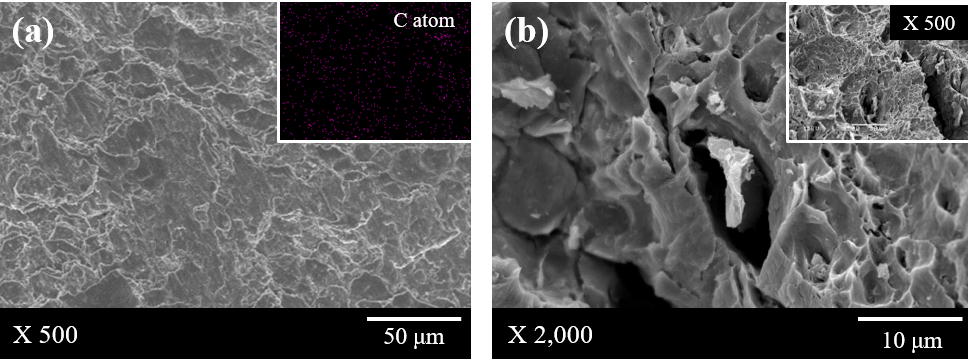
Figure 5. Cross section SEM images of Graphene reinforced aluminum matrix composites (GRAMCs) fabricated by ( a ) self-assembly coating and ( b ) ball- milling mixing method. Table 2. Comparison of the mechanical and thermal properties of all the samples.